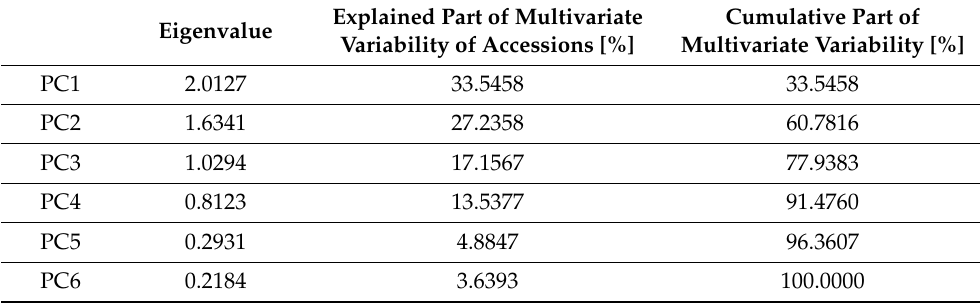
Table 1. Eigenvalues and values of the explained variance for the model from the mold and yeast-like fungi